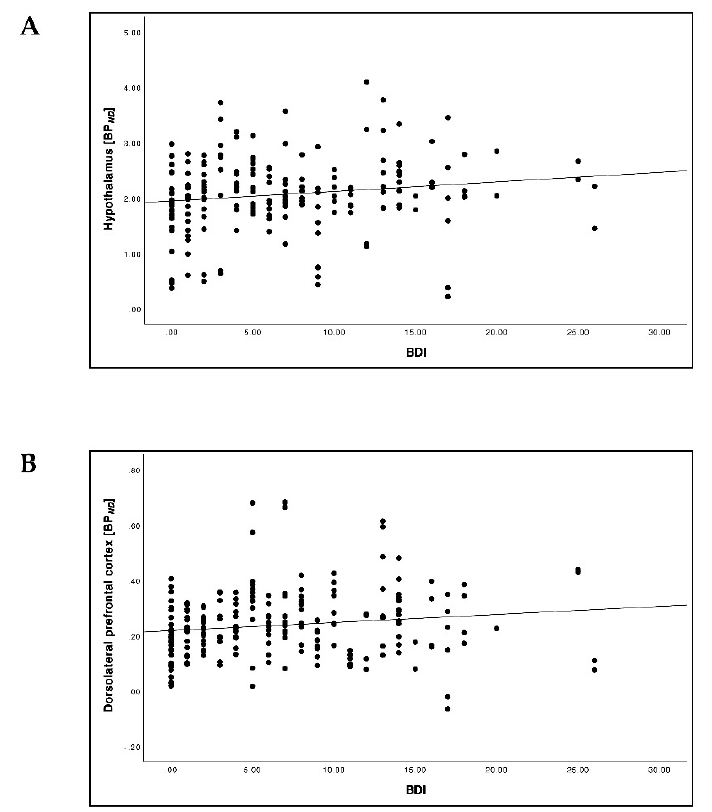
Figure 2. Relationship between BDI and 5-HTT BP ND in the hypothalamus ( A ) and dorsolateral prefrontal cortex (dlPFC) ( B ) (pooled baseline and follow-up data).